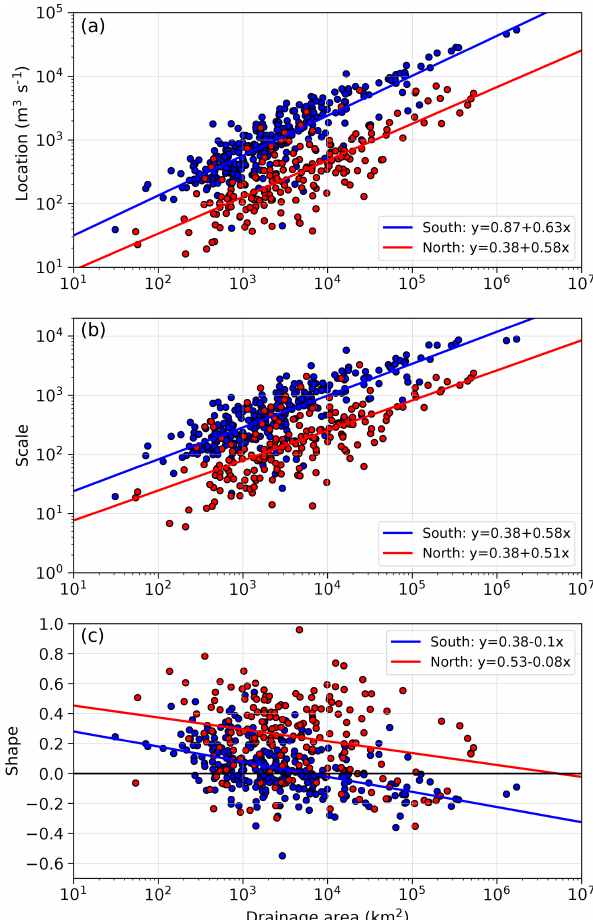
Figure 8. Scatterplots of the GEV parameters (a) location, (b) scale, and (c) shape as a function of drainage areas. Blue (red) scatters represent stations over south (north)